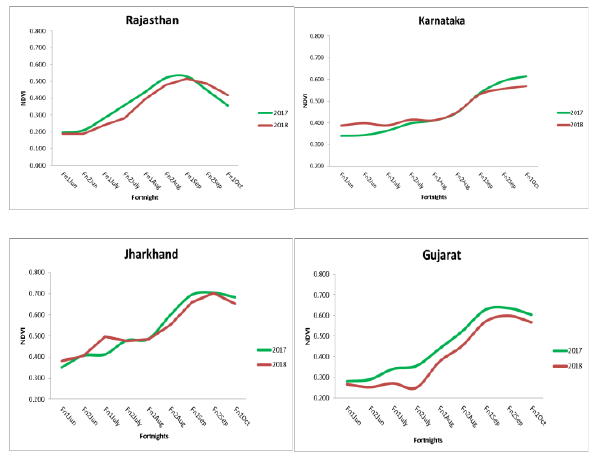
Figure 13. Sate wise comparison of NDVI profiles ( kharif season) for most drought prone states of